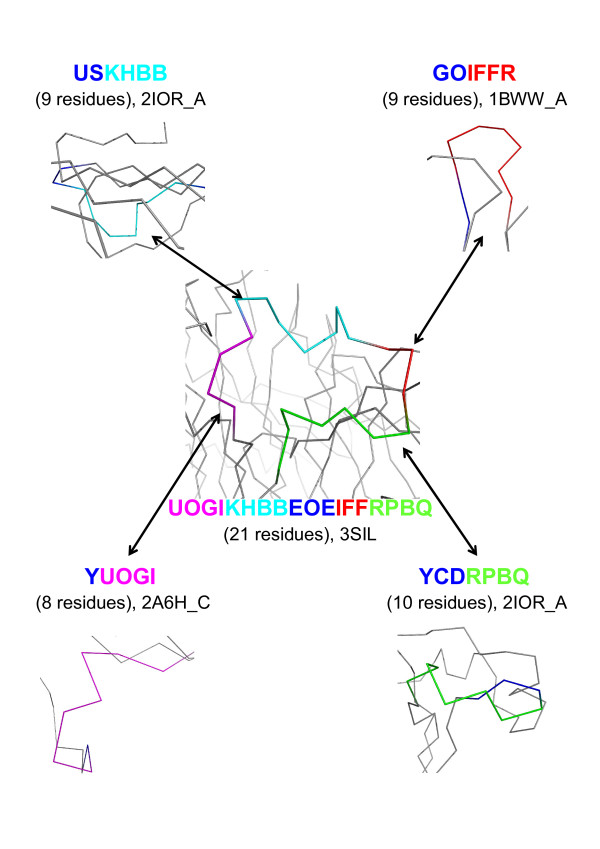
Recurrent words found both in long and short loops. A long loop of 18 structural letters (central figure) extracted from protein with pdb code 3SIL contains four words (UOGI, KHBB, IFFR, RPBQ) of Wset≥30. The protein is colored in gray, and the loop in blue except the four words UOGI in magenta, KHBB in cyan, IFFR in red and RPBQ in green. These four words are also seen in short loops in other structures. For each word, we indicate the structural letter pattern, the loop length within brackets and the pdb code of the protein structures. Structures are displayed with pymol [78].